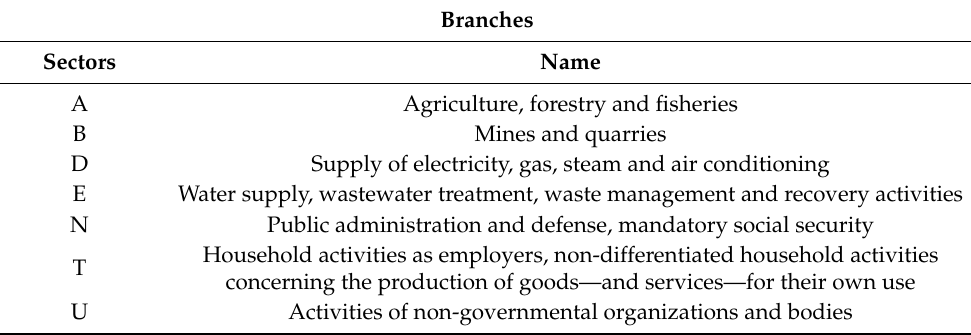
Table 1. Exempt branches.